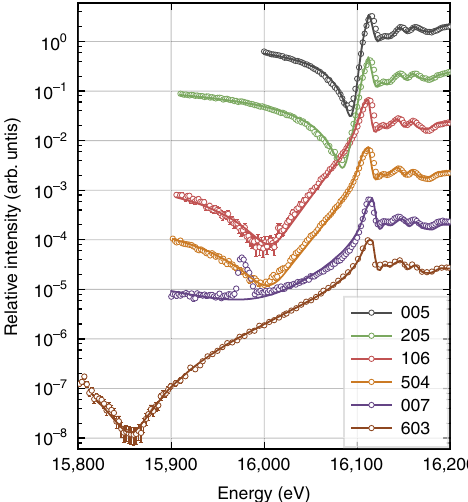
Fig. 4 Energy dependence for several Bragg re fl ections of the MFP phase. The Bragg intensity (open circles) was measured selectively for the strained MFP layer formed on the SrTiO 3 substrate. Solid lines show the calculation after re fi nement of z -positions of each atom in the unit cell. Error bars indicate the standard deviation calculated from the incident and diffracted beam intensity. For better visibility, the spectra have successively been scaled by a factor of 10 in the same order as they appear in the legend. The energy dependence of the 007 re fl ection differs strongly from the one acquired at room temperature before formation (compare Fig. 2). This clearly indicates a phase transition since lattice constants do not in fl uence Table 2 The structure of the MFP phase re fi ned in space group P 4 mm